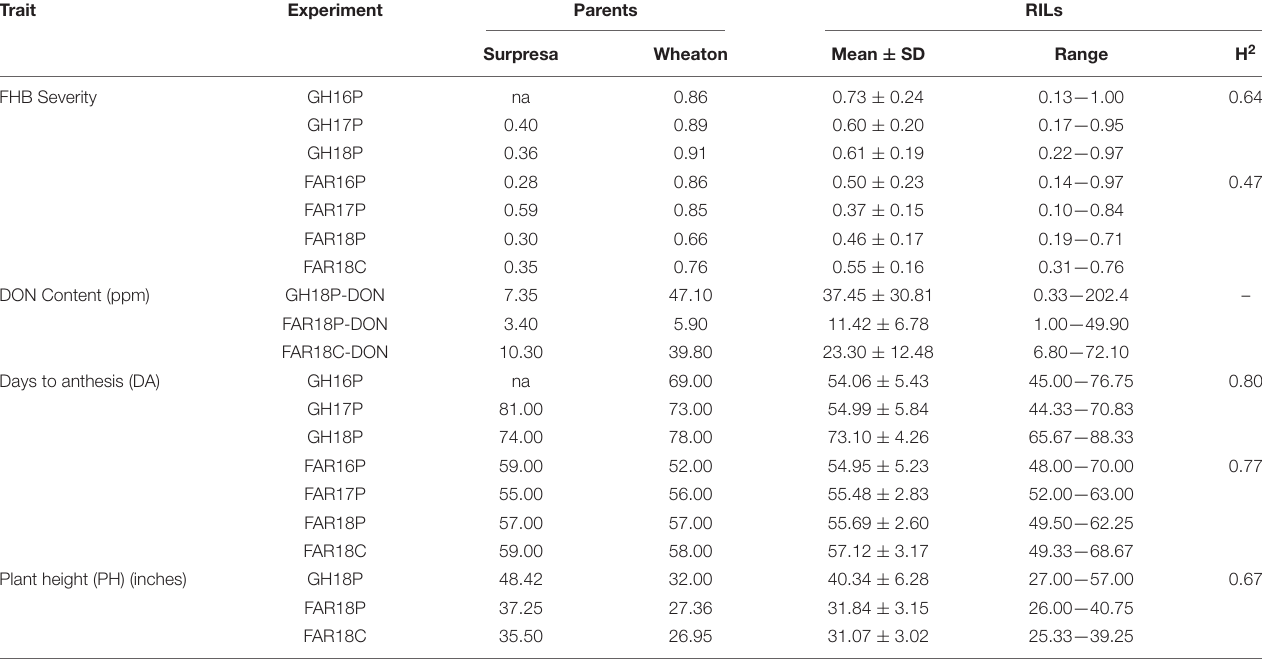
TABLE 1 | Phenotypes and broad-sense heritability of FHB related traits in Wheaton/Surpresa RILs and parents.